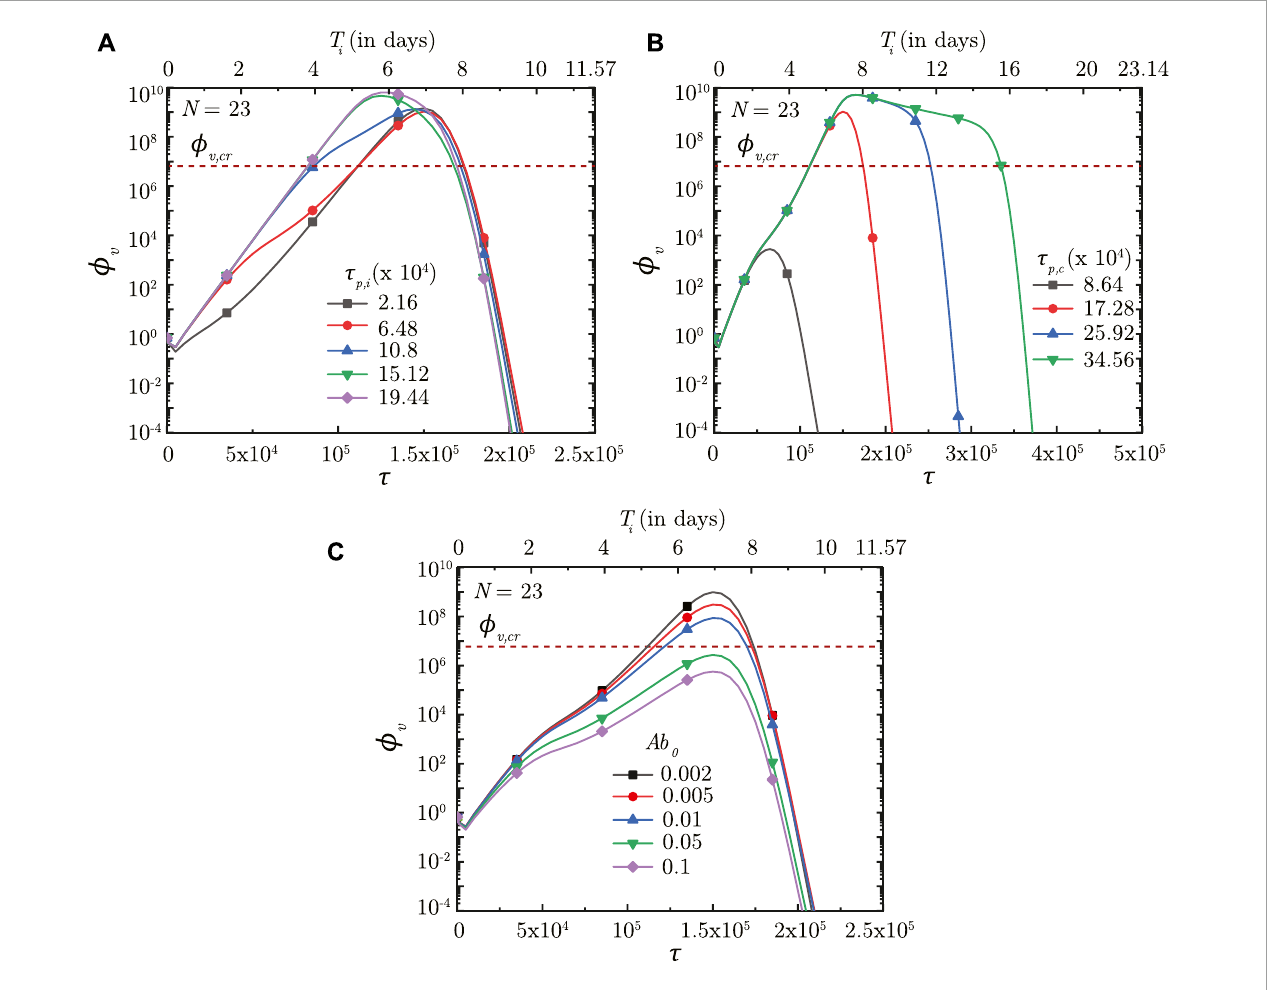
FIGURE 9 Temporal change in dimensionless virus concentration ( ϕ v ) at N = 23 (deep lung) with change in the time required for (A) interferon ( τ p , i ) and (B) cytotoxic T-lymphocytes ( τ p , c ) to reach their peak levels, and (C) with change in the initial antibody level ( Ab 0 ) in the infected individual. The results are shown with respect to dimensionless time ( τ ) as well as a dimensional time ( T i ) post infection onset with the breathing time period ( T b = 4s) considered for obtaining the dimensional time (see Eq. 7 ). The dotted line indicates the critical viral load ( ϕ v , cr ) in the deep lung required for pneumonia onset (Fajnzylber et al.,